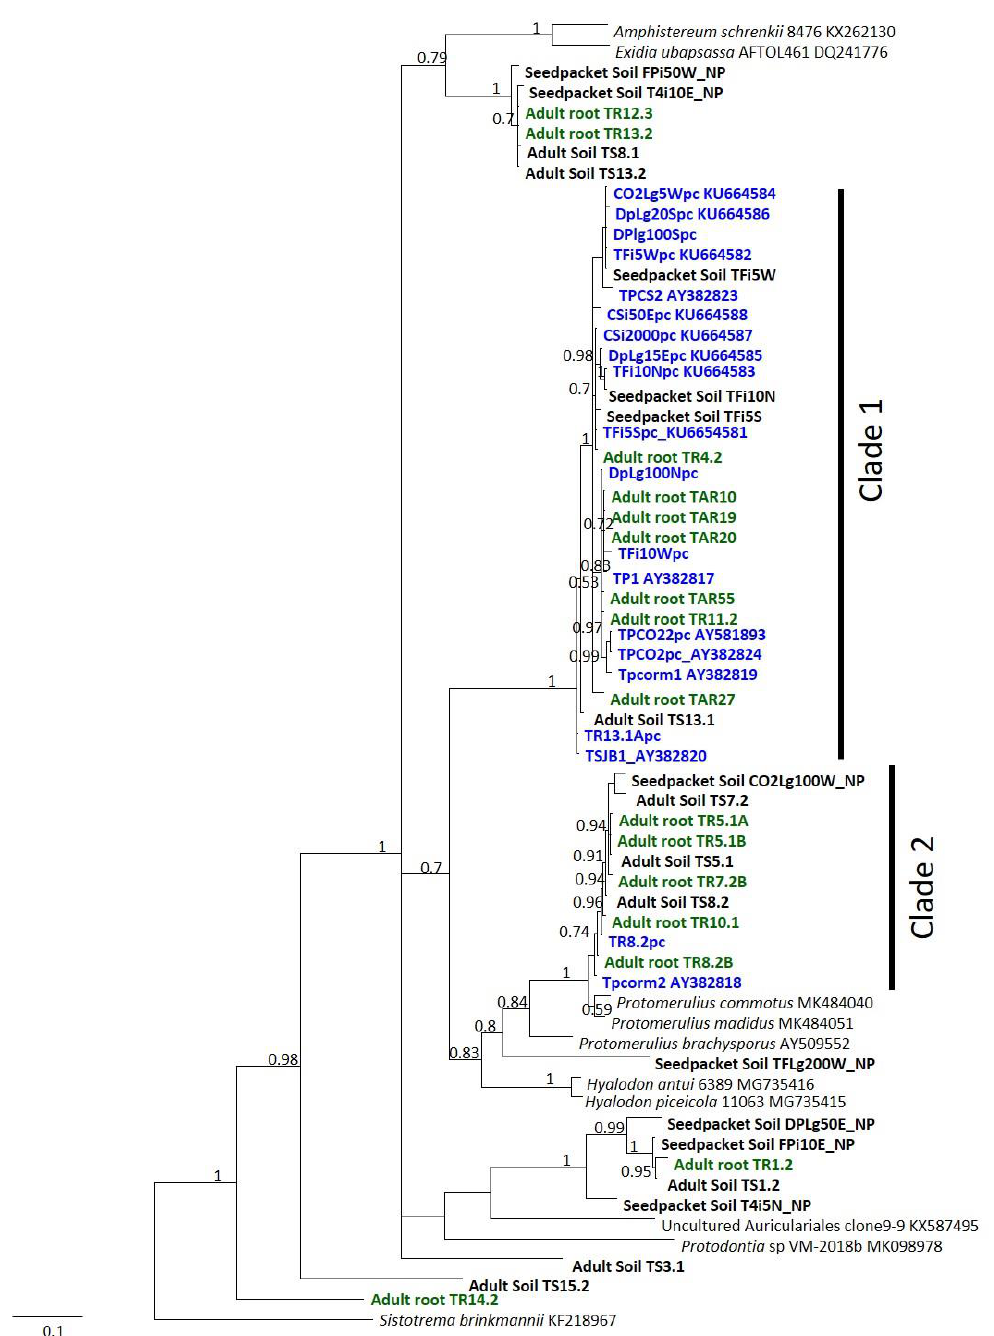
Figure 1. Bayesian phylogenetic tree based on ITS sequences showing Auriculariales fungi from protocorms (blue), adult roots (green), and soil samples (bold, black). Posterior probabilities ≥ 0.7 are given to show node support. The delimitation of the two clades of fungi that include protocorm fungi is indicated by vertical bars labeled Clade 1 and Clade 2. Labels for sequences from soil samples associated with T. discolor adult roots begin with “Adult soil”, followed by the sample number. Names of sequences from adult orchid roots begin “Adult root”, followed by the sample number. Names of soils adjacent to seed packets begin with “Seedpacket Soil”. Labels for soil samples adjacent to seed packets without protocorms end with “_NP”. Labels for sequences from protocorms in previous studies end with their Genbank accession number.